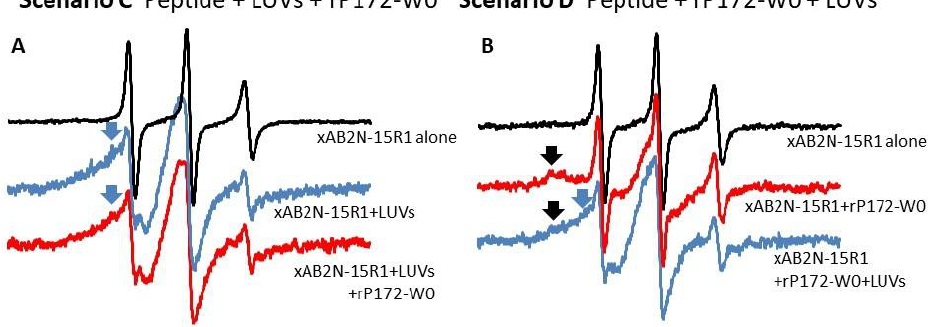
Figure 9. ( A ) EPR spectra of 15 µM xAB2N spin-labeled at position 15 in 10 mM Tris, pH 7.4, 50 mM NaCl, with 600 µM LUVs, followed by 15 µM rP172-W0, added in, as in Scenario C depicted in Figure 5. ( B ) EPR spectra of 15 µM xAB2N spin-labeled at position 15 in 10 mM Tris, pH 7.4, 50 mM NaCl, with 15 µM rP172-W0, followed by 600 µM LUVs, added in, as in Scenario D depicted in Figure 5. Black arrows indicate the immobilized spectral component characteristic of protein contacts; blue arrows indicate the intermediately immobilized spectral component characteristic of peptide–LUV interaction.